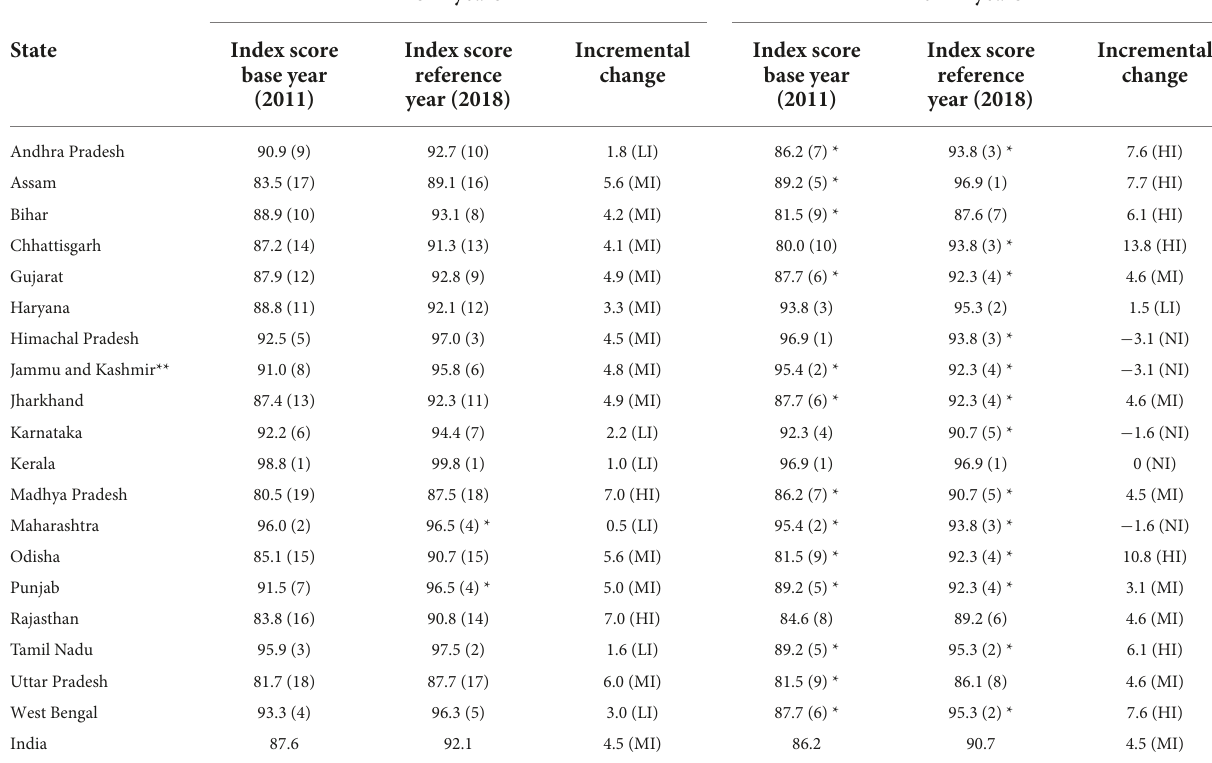
TABLE 2 Incremental changes in mortality index scores of age groups 0–4 and 5–14 years for rural Indian women from the base year to reference